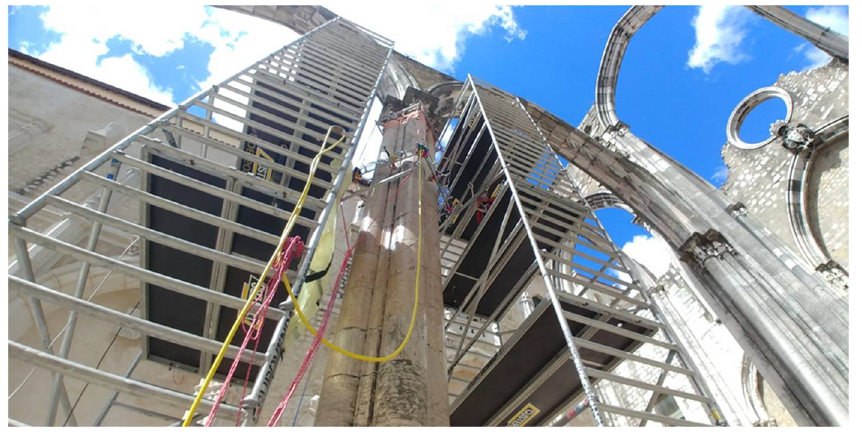
Figure 20. Tomography system inspecting the shaft.